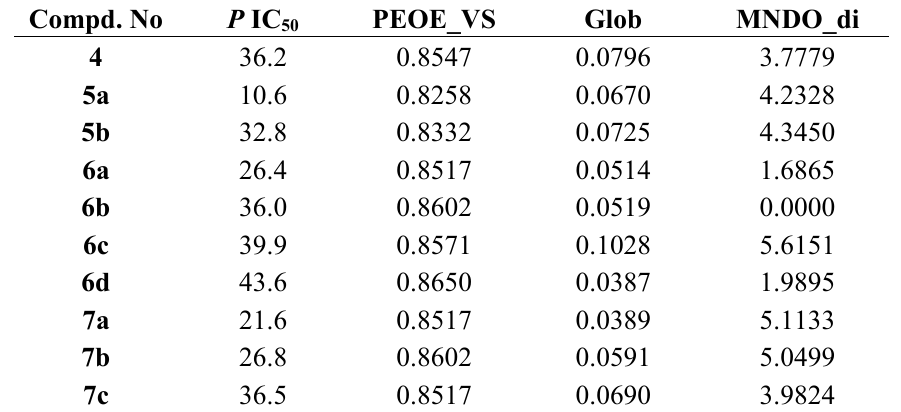
Table 3. The most relevant discriptors derived for modeling the antitumor activity.